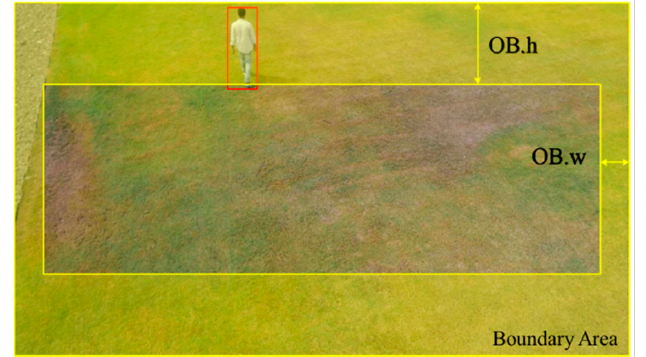
Figure 10. The search range is switching to boundary area when the object is out of bounds.